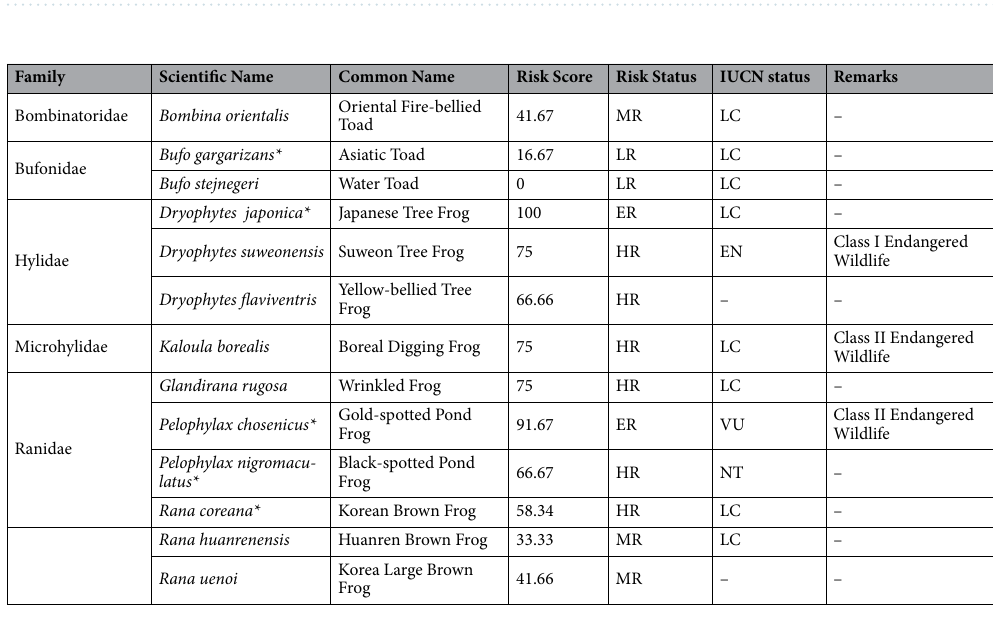
Figure 4. The proportion of habitat use by Lithobates catesbeianus within their home range in the -( A ) breeding and non-breeding seasons, ( B ) breeding season, ( C ) non-breeding season, and ( D ) comparison of habitat use by male–female individuals during breeding and non-breeding seasons.